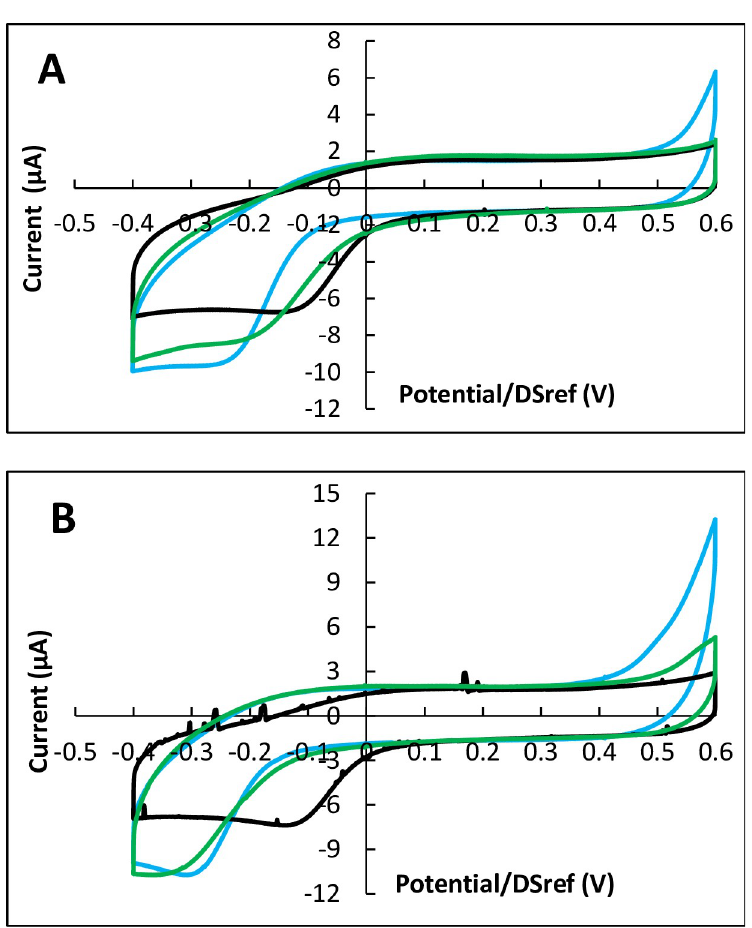
Fig 9. Cyclic voltammetry of MRC5 after 24 hours’ incubation. Inoculation with 50 000 cells; potential scan rate 10 mV.s -1 ; A) carbon electrodes; B) carbon electrodes coated with CNT. Black: With cells; blue: Control without cells; green: Supernatant; in each case dotted lines are duplicates. Potentials are expressed vs. the DropSens pseudo-reference (DSref), values vs. SHE can be obtained by adding 0.290 V.